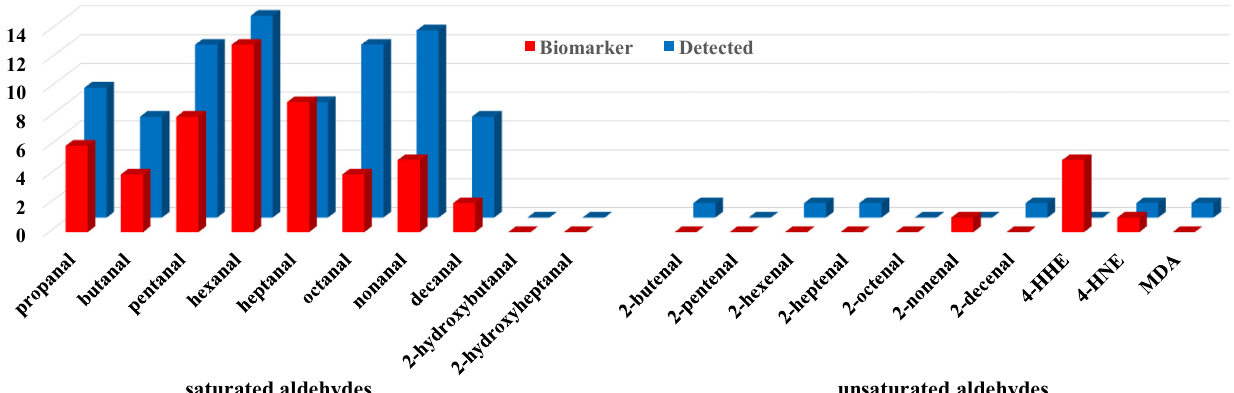
Figure 4. Number of literature reports for each aldehyde that was either detected (blue) in the exhaled breath of lung cancer patients or deemed a biomarker (red) of lung cancer. The term biomarker denotes a statistically significant increase in the EB of LC patients compared to healthy controls. Total reports for a given aldehyde are the sum of the red and blue columns.